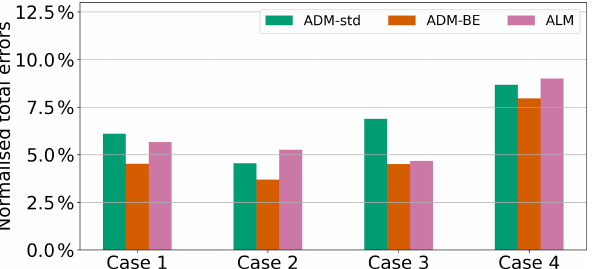
Figure 16. Normalised total power errors of the three-turbine array. The errors are normalised by the total measured power of the wind turbine array in each case. Case 1: γ = (0 , 0 , 0 ◦ ), zero offset; Case 2: γ = (25 , 15 , 0 ◦ ), zero offset; Case 3: γ = (0 , 0 , 0 ◦ ), D/ 3 offset; Case 4: γ = (20 , 20 , 0 ◦ ), D/ 3